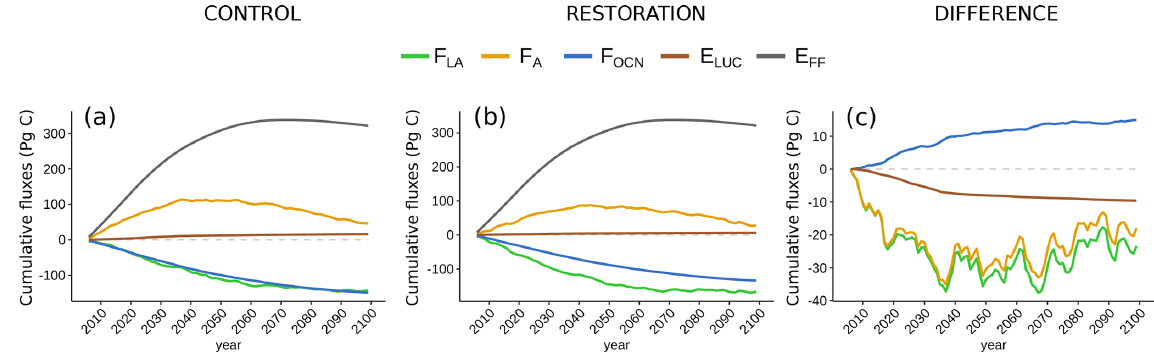
Figure 4. Effect of tropical land-use stop and secondary succession on cumulative global carbon fluxes (2006–2100CE) in (a) control, (b) restoration, and (c) cumulative difference between restoration and control simulation for land–atmosphere flux ( F LA , green), ocean– atmosphere flux ( F OA , blue), deforestation emissions ( E DEFOR , brown), atmospheric carbon ( F A , orange), and fossil fuel emissions ( E FF , grey). The difference in fossil fuel emissions is zero and not plotted. Dashed line indicates zero; fluxes below zero indicate a carbon benefit in the restoration simulation with respect to the control simulation. Note the different vertical scales. Table 2. Cumulative global fluxes of all carbon cycle components: land–atmosphere flux ( F LA ), ocean–atmosphere flux ( F OA ), deforestation emissions ( E DEFOR ), fossil fuel emissions ( E FF ), and total net flux to atmosphere ( F A ) in the restoration simulation, the control simulation, and their differences. F LA is the difference between heterotrophic respiration ( R h ) and NPP. “Interactive” represents calculated by the model, and “Prescribed” represents taken from input data. Negative values represent a carbon sink to the atmosphere.